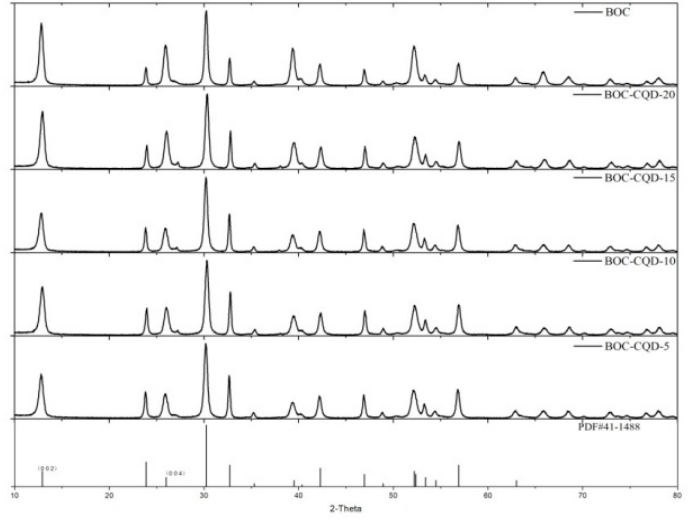
Figure 4. X-ray diffraction (XRD) patterns of as-prepared samples.